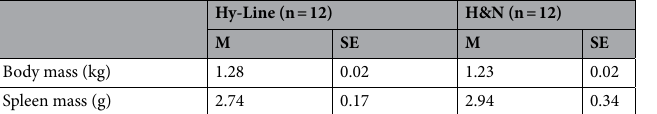
Table 4. Descriptive statistics for body and spleen masses of Hy-Line and H&N strain pullets, sampled from the rearing farm to provide a strain-baseline for comparisons between the adult housing systems. M, mean; SE, standard